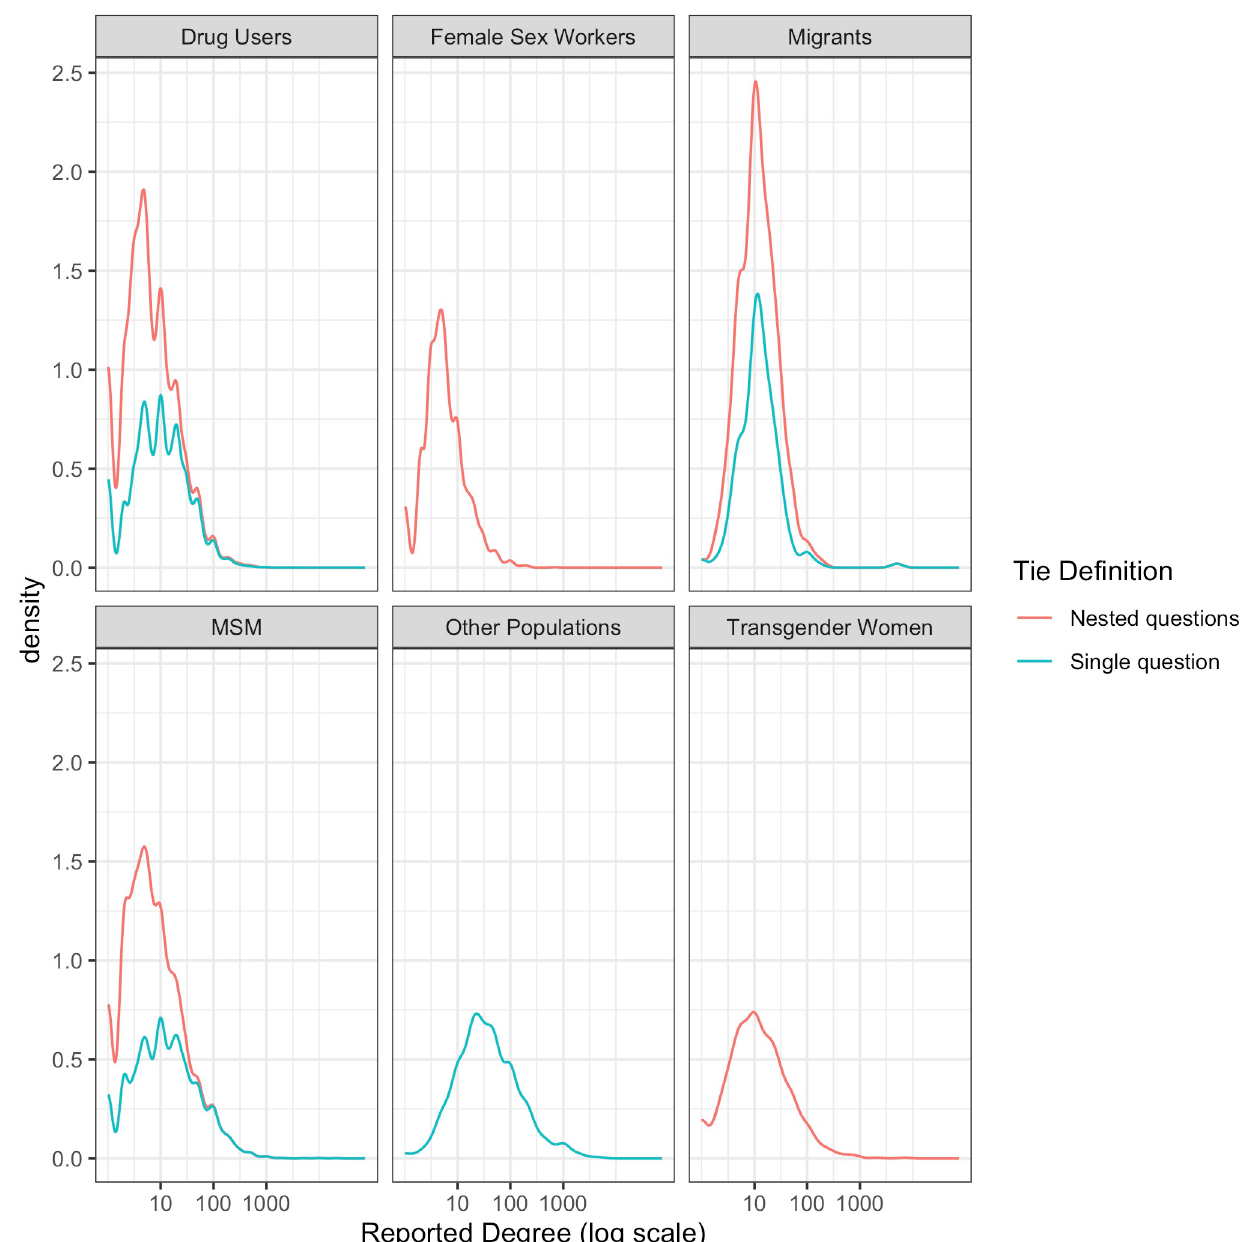
Fig 7. Network degree by tie definition. Distribution of reported network degree based on population type and tie